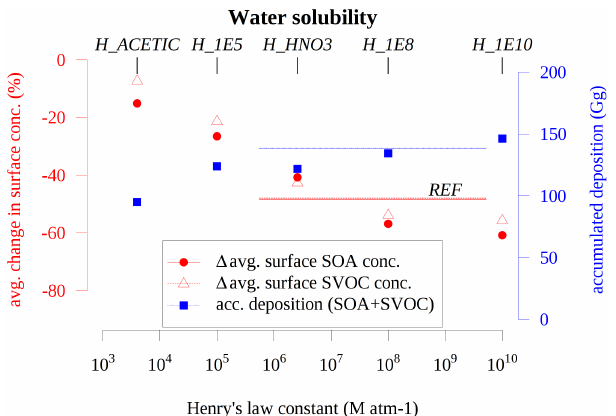
Figure 9. Sensitivity to water solubility of SVOCs ( H ∗ ). Shown are continental US averages/totals of changes in surface level SOA (red dots)/SVOC (red triangles) concentrations and accumulated depo- sition of SOA + SVOCs (blue rectangles). The results of the REF simulation using the range of H ∗ values derived in Hodzic et al. (2014a) are indicated as